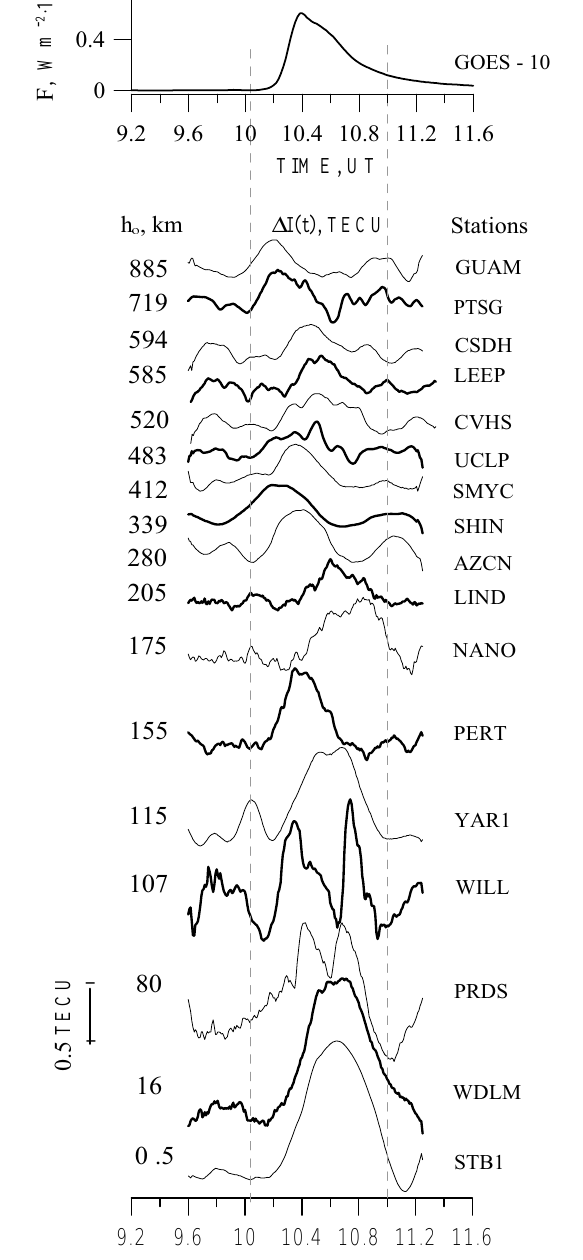
dependencies are drawn by lines of a different thickness.